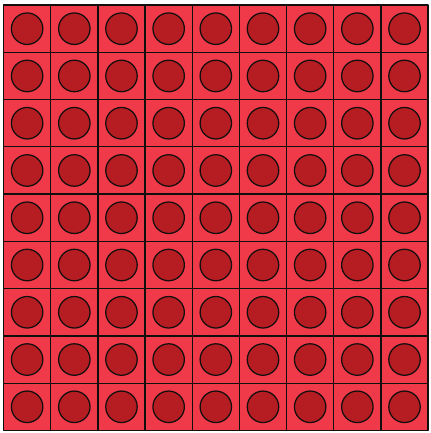
Figure 3: Scheme of fuel